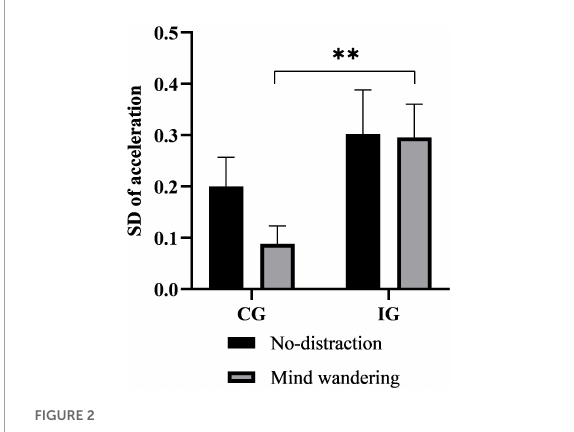
FIGURE2 The effect of mind wandering (MW) on acceleration. ∗∗∗ P < 0.001; ∗∗ P < 0.01; ∗ P < 0.05. MW, mind wandering; SD, standard deviation; IG, insomniac group; CG, control group.